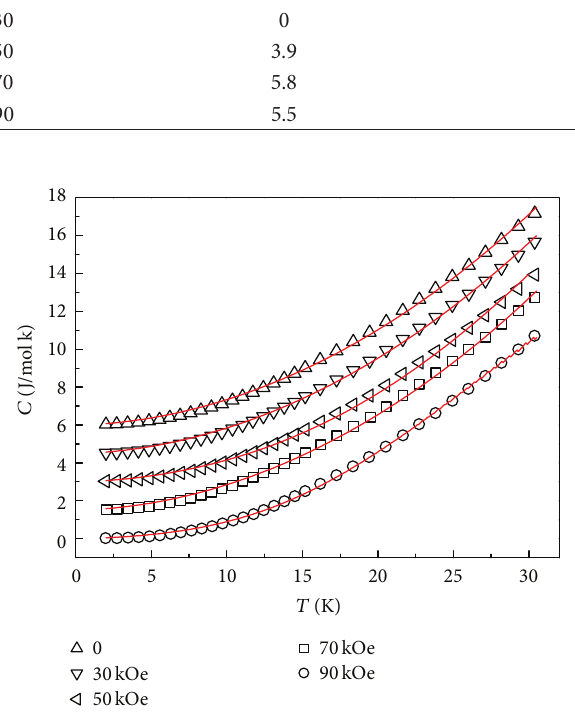
Figure 1: The specific heat versus temperature curve of poly- crystalline Pr 0.65 Ca 0.35 MnO 3 at low temperature under different magnetic fields. Solid line is fit to the data with